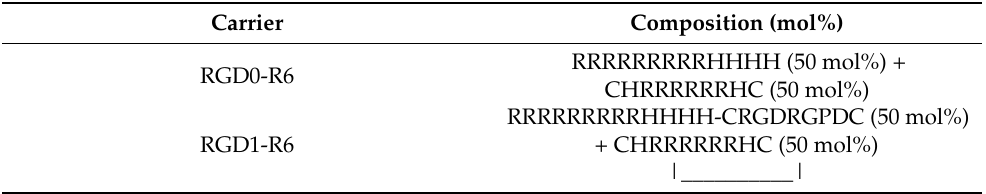
Table 1. Design and composition of the